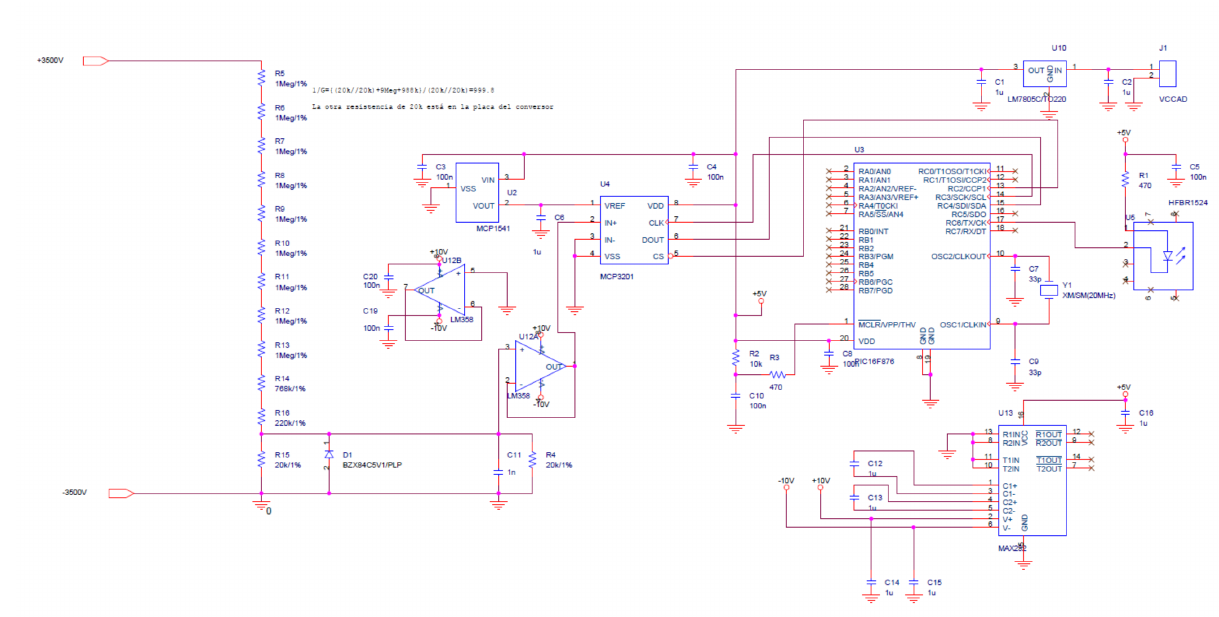
Figure 11. The High Voltage Measuring Board.